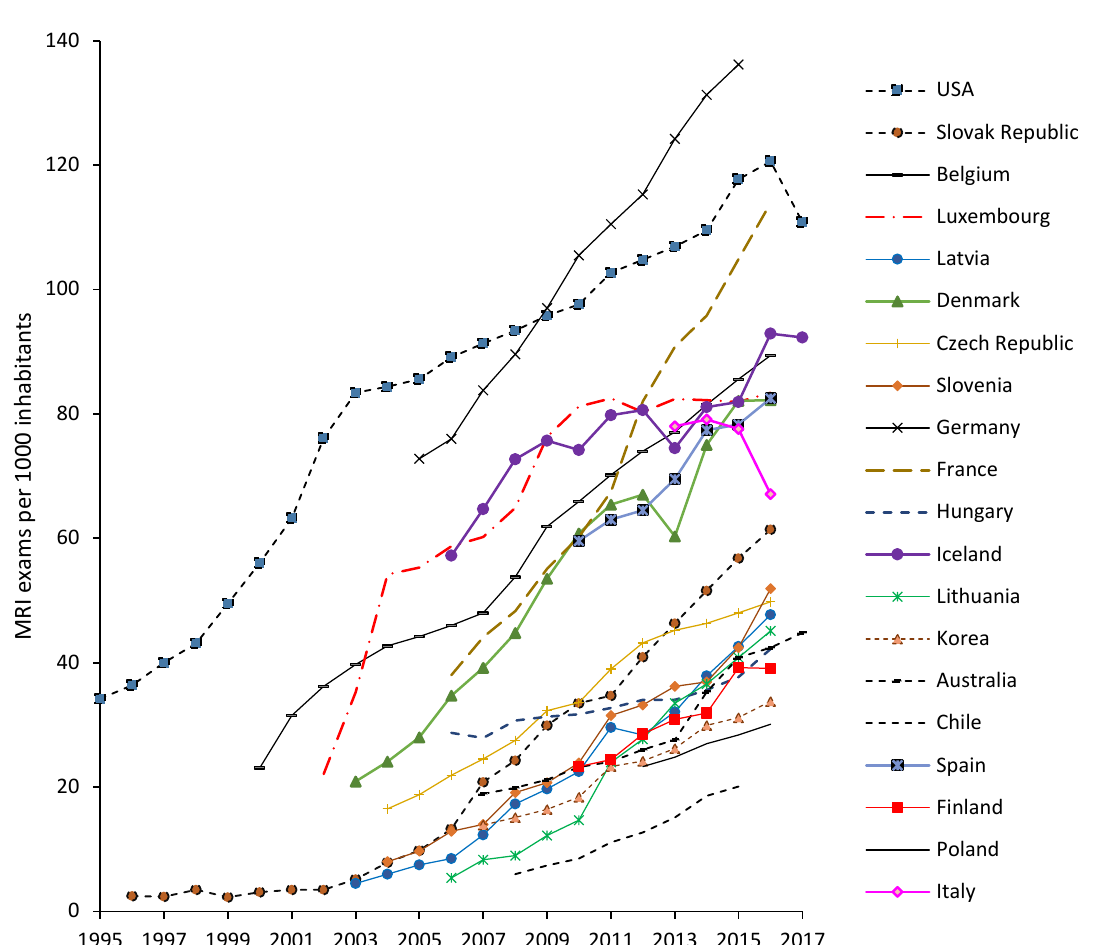
Figure 4. Long-term trend of the number of MRI exams per 1000 inhabitants performed in a range of countries [160].